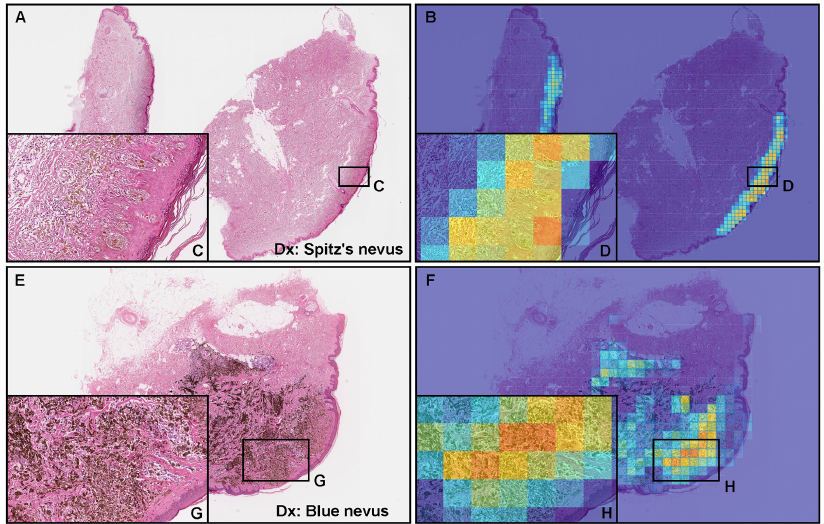
Figure 6. Two examples of false positive predictions of melanoma using the × 20, 512 × 512 px model. According to the histopathological diagnostic (Dx) reports, ( A ) was diagnosed as a Spitz nevus and ( E ) a blue nevus. Both Spitz’s nevus cells ( C ) and blue nevus cells ( G ) are morphological mimics of melanoma cells. The heatmap images ( B , F ) show false positive predictions and ( D , H ) correspond, respectively, to ( C , G ). Red indicates a high probability and blue indicates a low